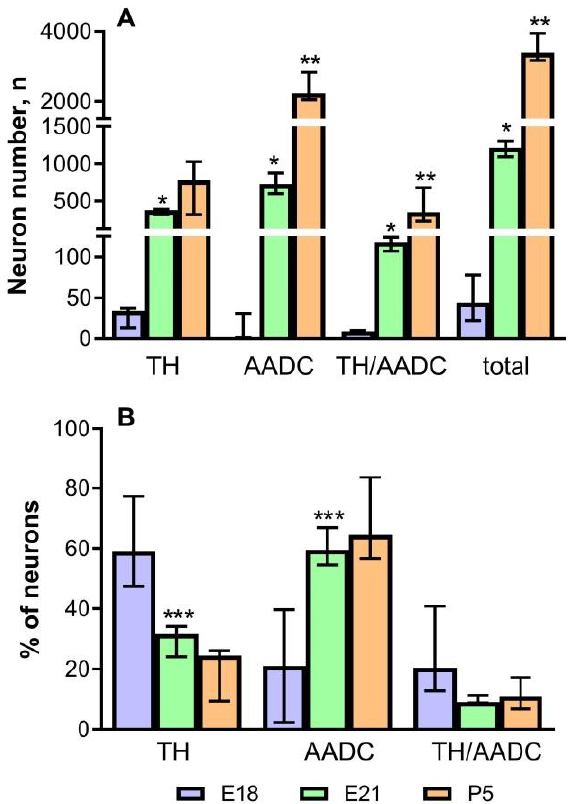
Figure 6. The total number of neurons immunopositive only for tyrosine hydroxylase (TH), only for aromatic L-amino acid decarboxylase (AADC) and for both dopamine-synthesizing enzymes (TH/AADC) ( A ), and their proportions (in %) of the total number of neurons that are immunopositive for dopamine-synthesizing enzymes ( B ), in the periventricular nucleus in rats on embryonic day (E18), on E21 and on postnatal day 5 (P5). * p < 0.05, significant differences between the total number of neurons immunopositive for the same dopamine-synthesizing enzymes on E18 and E21; ** p < 0.05, significant differences between the total number of neurons immunopositive for the same dopamine-synthesizing enzymes on E21 and P5; *** p < 0.05, significant differences between the proportions of neurons (in %), immunopositive for the same dopamine-synthesizing enzymes, at E18 and E21 (unpaired Wilcoxon test). Data are presented as median with interquartile range.